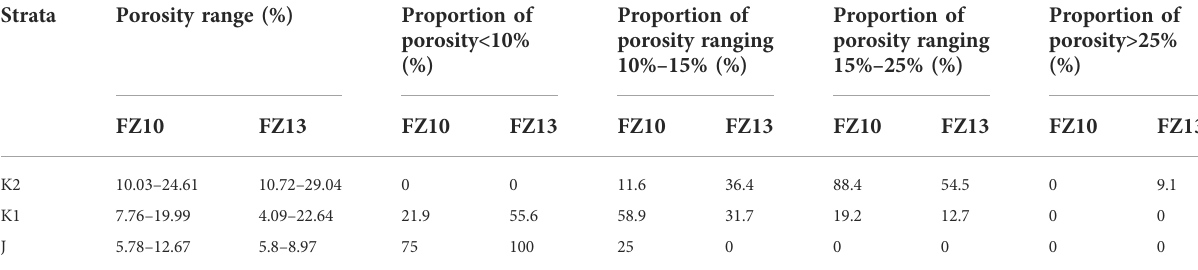
TABLE 1 Porosity distribution of the Mesozoic reservoir across wells FZ10 and FZ13 estimated from three strata (J, K 1 , and K 2 ).